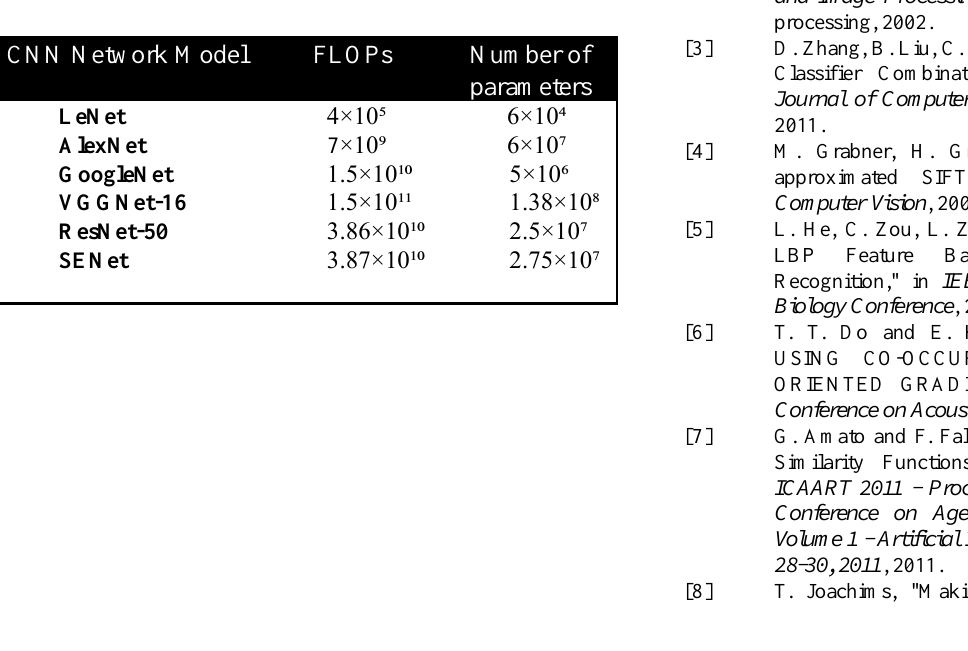
Table 2. Time complexity and space